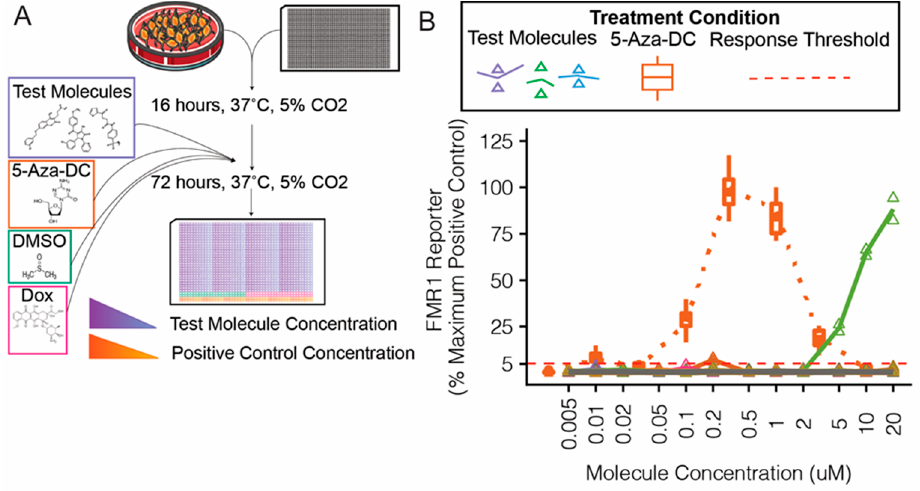
Figure 4. Confirmatory validation screen of candidate molecules for FMR1 reporter activity in neural progenitor cells. Candidate small molecules were selected for secondary screening on the basis of response in primary screen and availability ( A ). Reporter neural progenitor cells (NPCs) were treated for 72 h with candidate molecules from the MLPCN library, 5-aza-2 (cid:48) -deoxycytidine (5-Aza-DC, positive control, orange boxes and line), or DMSO (vehicle, gray triangles, and line) ( B